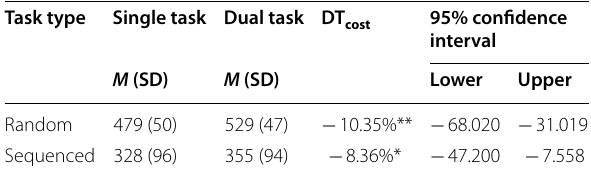
Table 1 Reaction times (in milliseconds) for all conditions in Experiment 2a with the difference between single- and dual-task conditions expressed by dual-task costs (DT ) cost